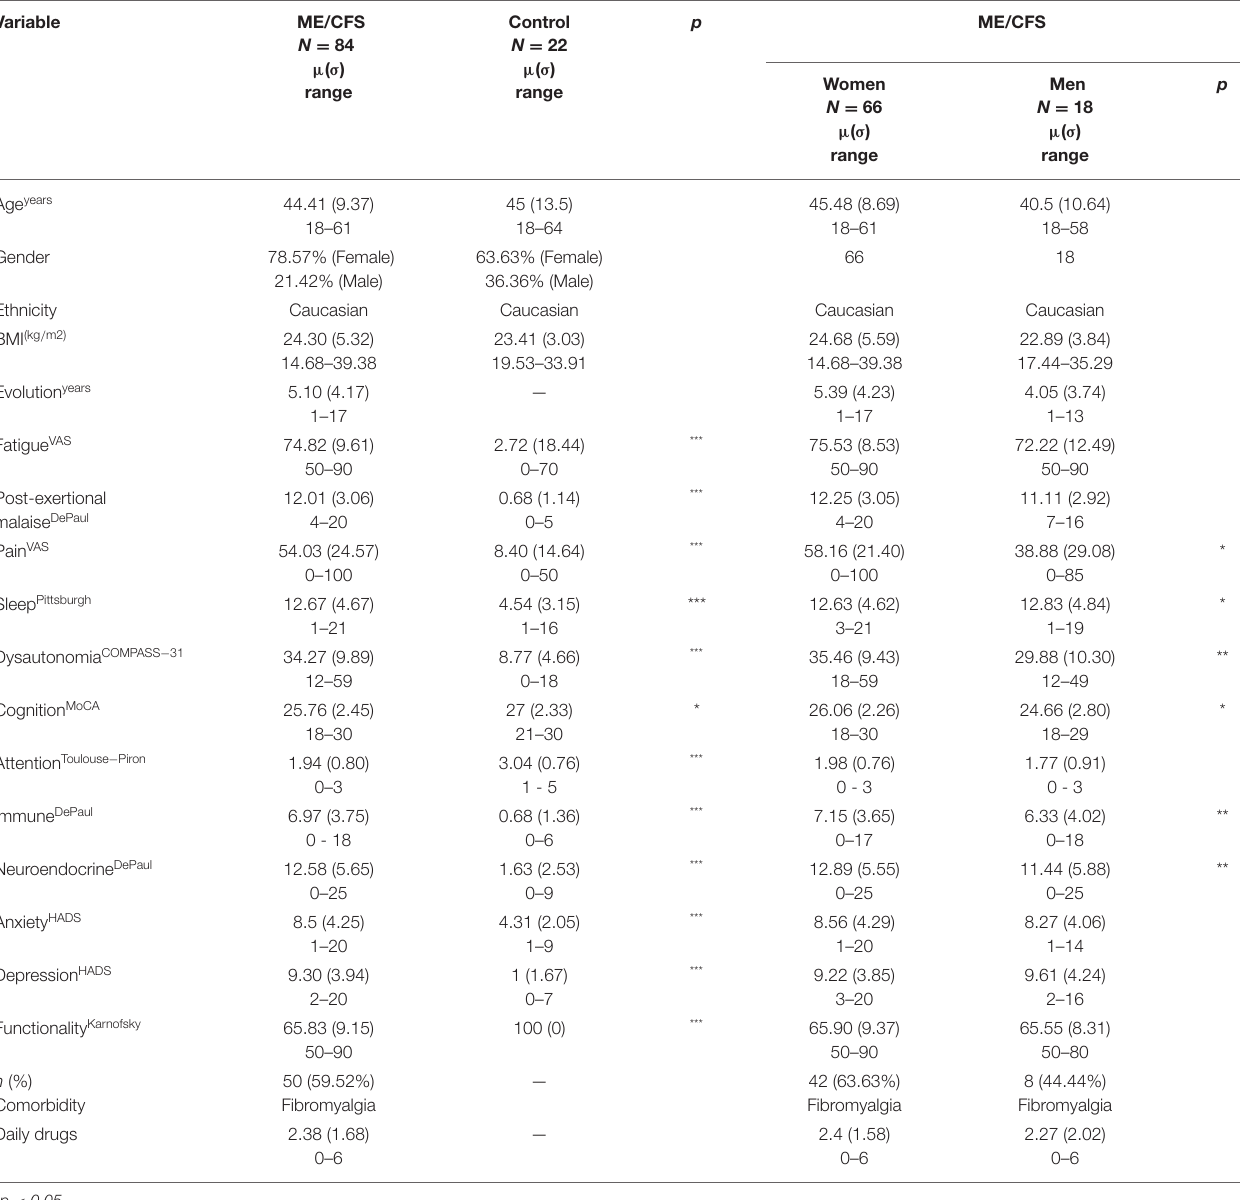
TABLE 1 | Data of the tests used in the clinical evaluation.